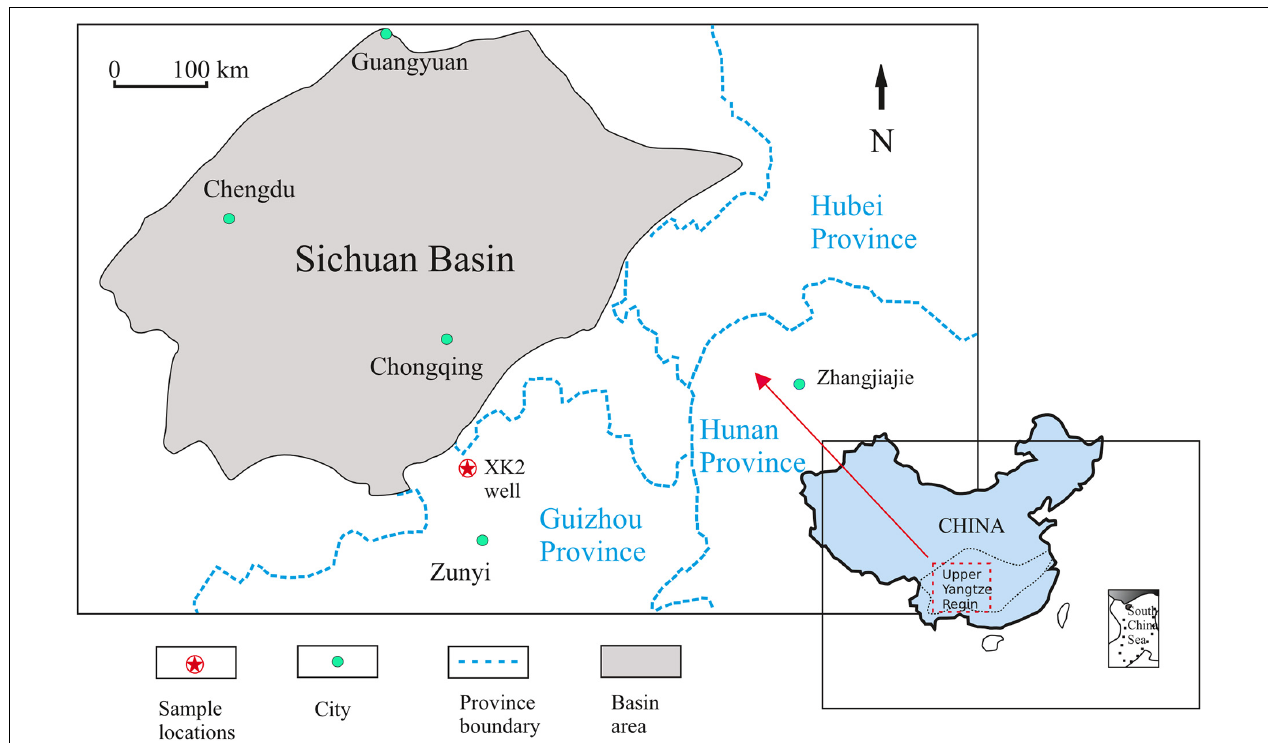
FIGURE 1 | Map showing the location of the well XK2 [modified from Cheng et al. (2018)].